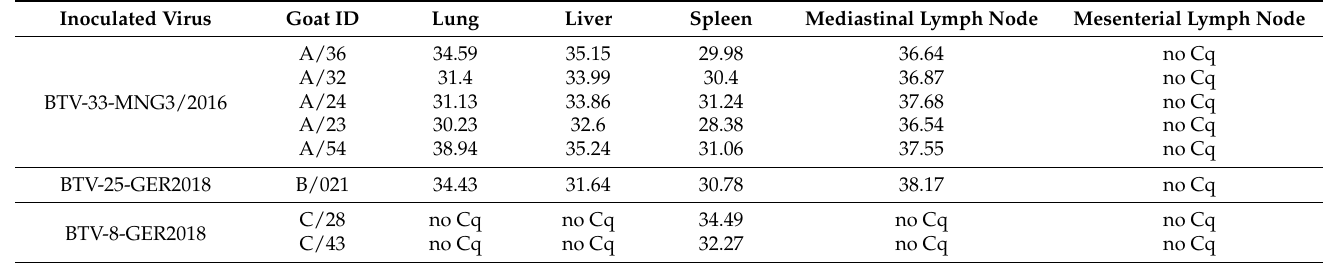
Table 1. RT-qPCR results (Cq values = cycle of quantification) of the organs of the viraemic goats during experimental infection. Organs were taken during necropsy at 42